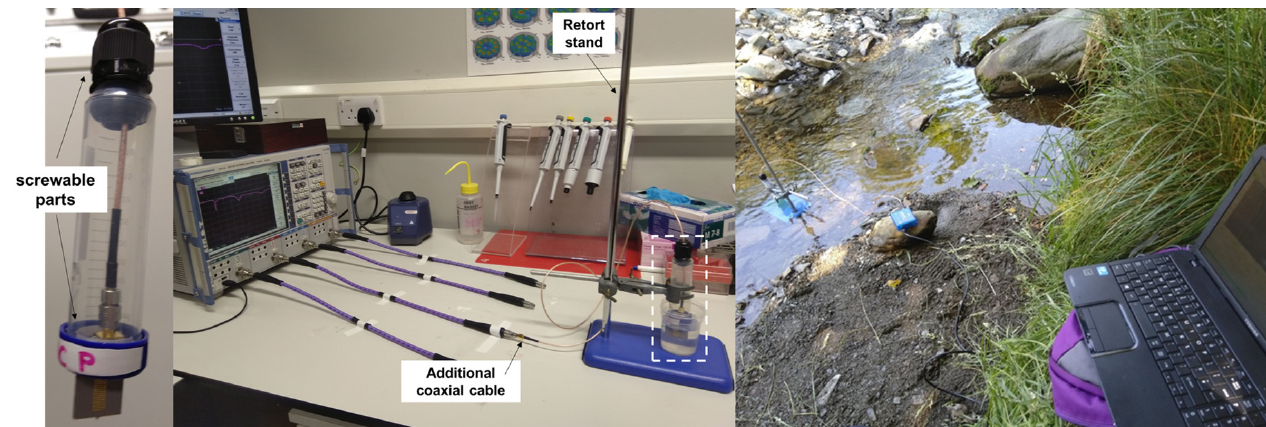
Figure 6. ( a ) Close up of the sensor and its structure with screwable parts; ( b ) measurement configuration adopted using a ZVA 24 configured with an additional coaxial cable and a retort stand for holding the waterproofed microwave sensor in place probing a water sample; ( c ) configuration for in situ measurements using a miniVNA tiny and a laptop as output